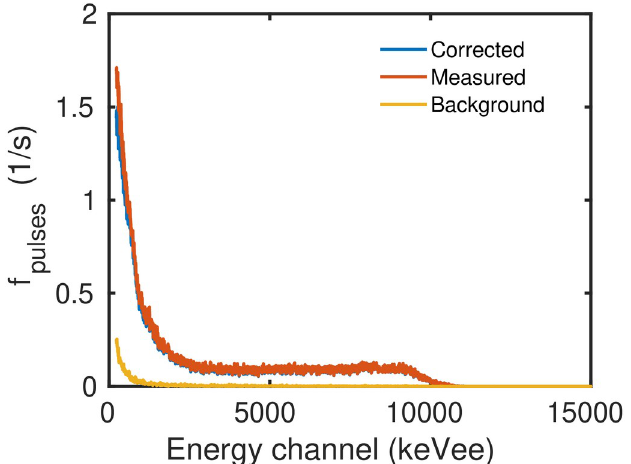
Fig 3: Response of scintillator with THIO luminophore to neutrons of energy 19 MeV.